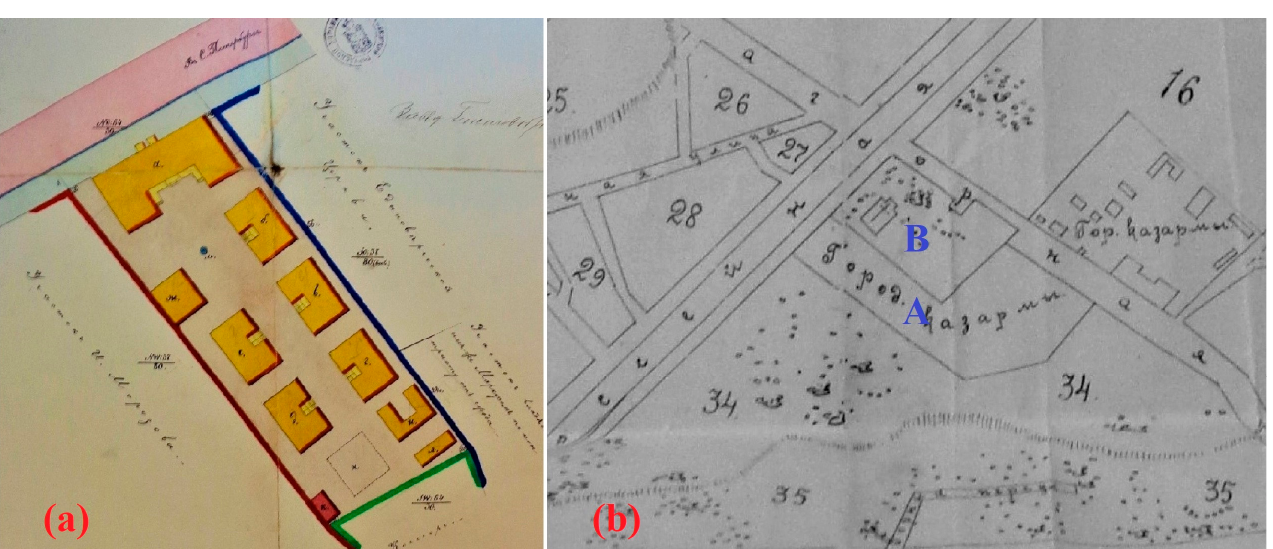
Figure 2. Edinoverie Church of St Andrew (source: Kaunas Public Library).